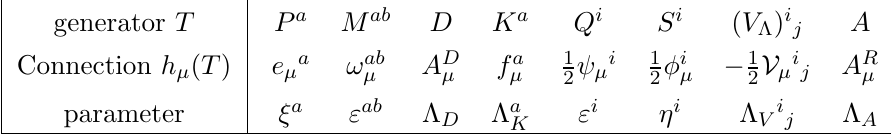
Table 7 . Table of superconformal gauge (cid:12)elds and transformation